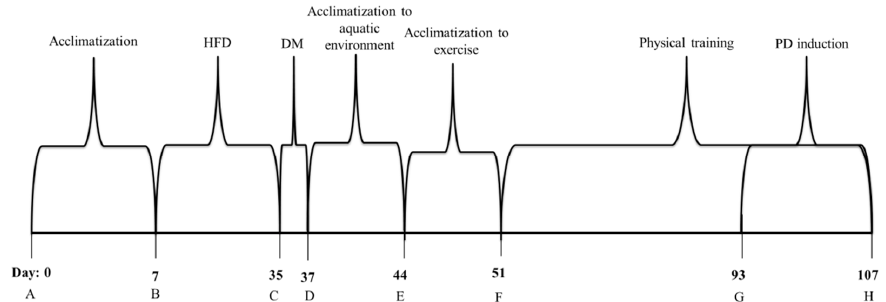
Figure 1. Flowchart of the experimental design. A —Acclimatization phase. B —High fat diet induction